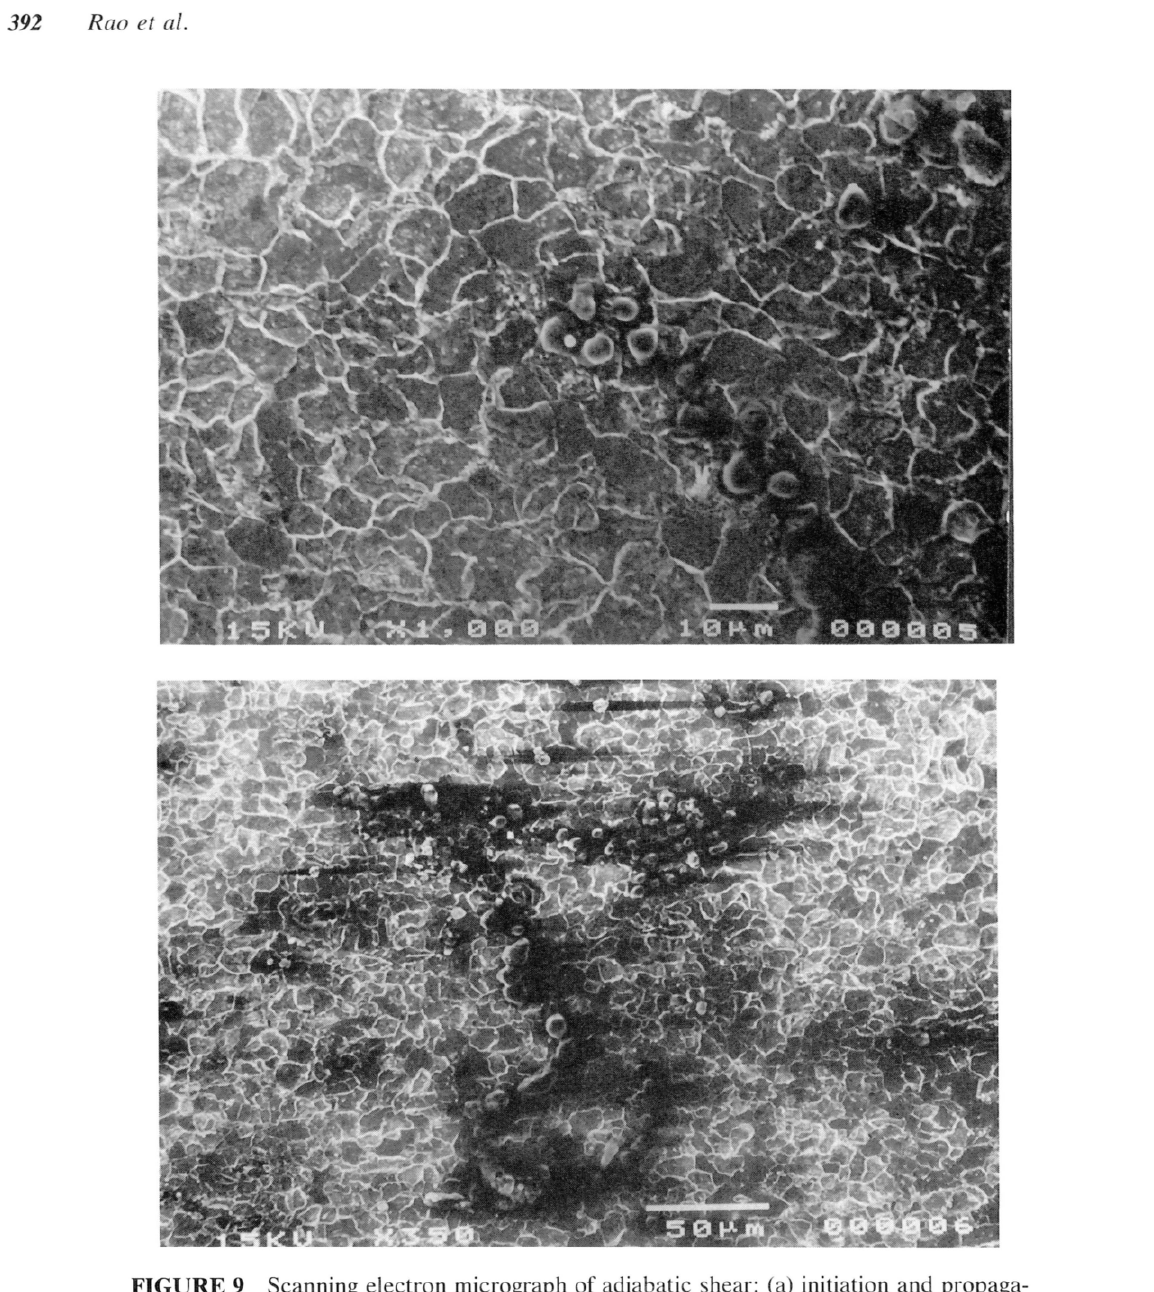
FIGURE 9 Scanning electron micrograph of adiabatic shear: (a) initiation and propaga tion of a crack and (b) multiple crack